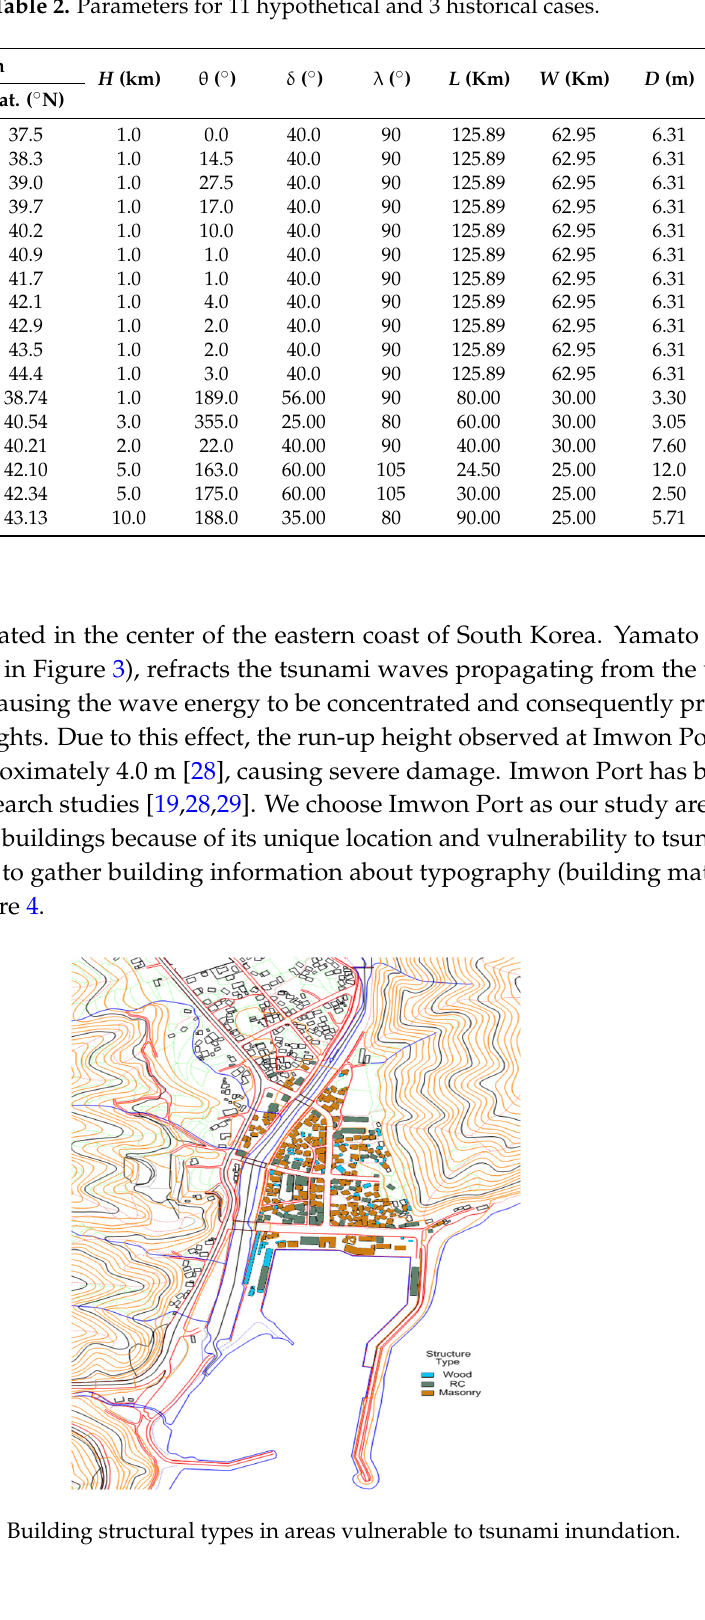
Table 2. Parameters for 11 hypothetical and 3 historical cases.